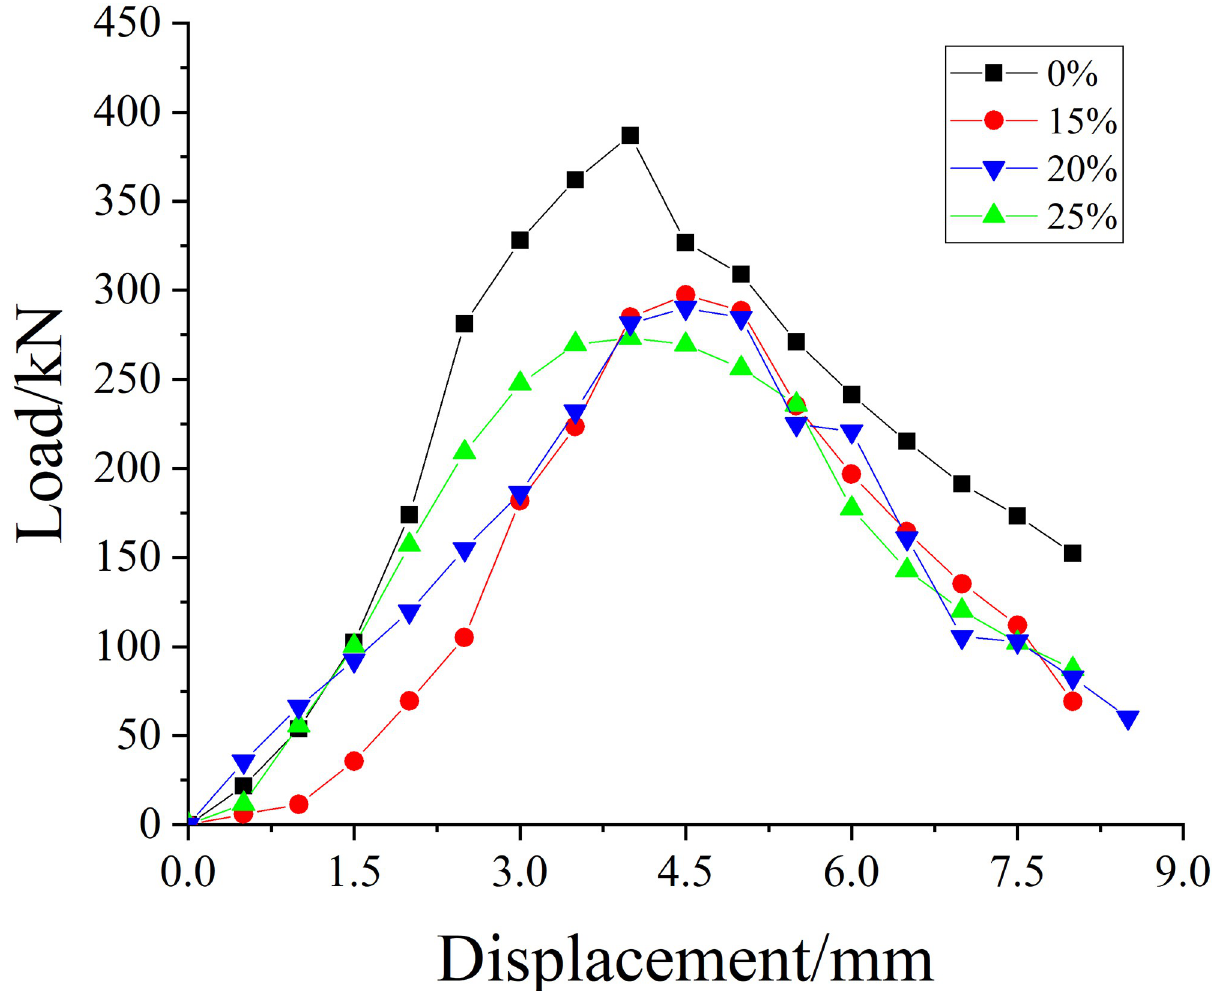
Fig 8. Skeleton curves of specimens with different concentrations of salt solution.